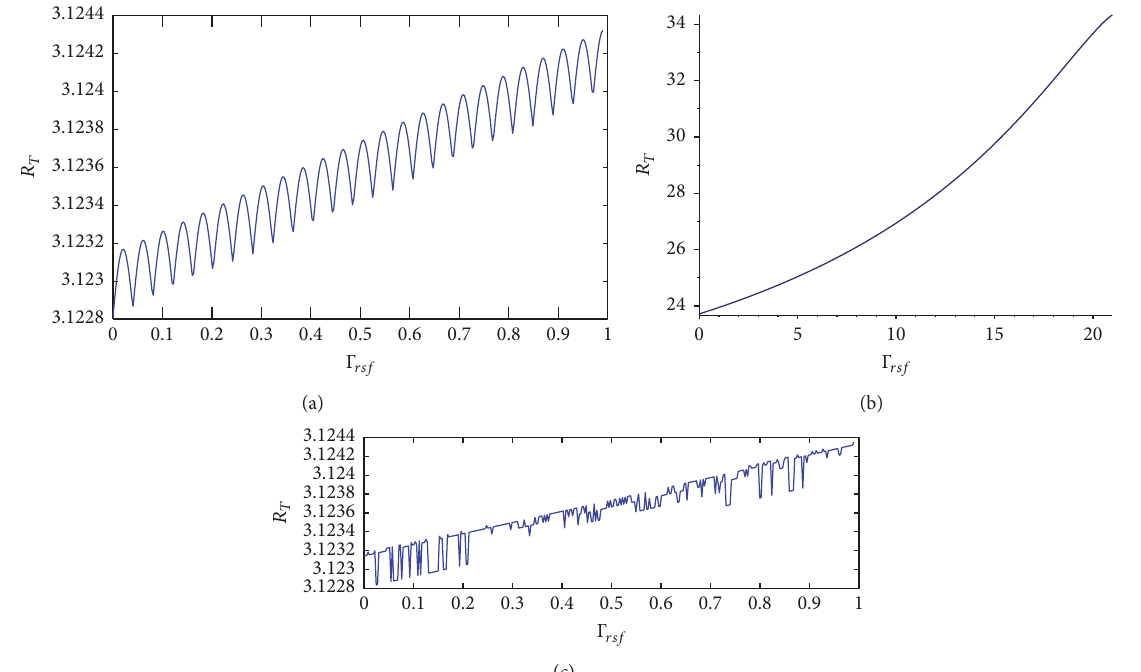
Figure 11: The effect of increased infection rate to fleas from the infectious rodents ( 𝐼 𝑅𝑆 ) on the periodic reproduction number.